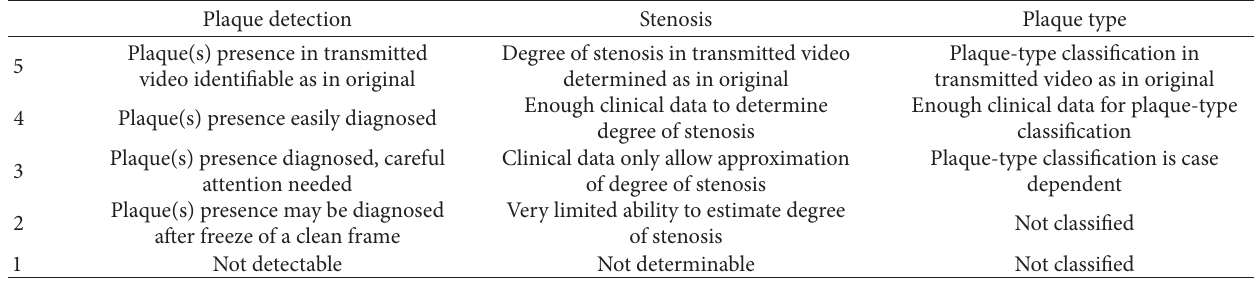
Table 2: Clinical evaluation rating system.